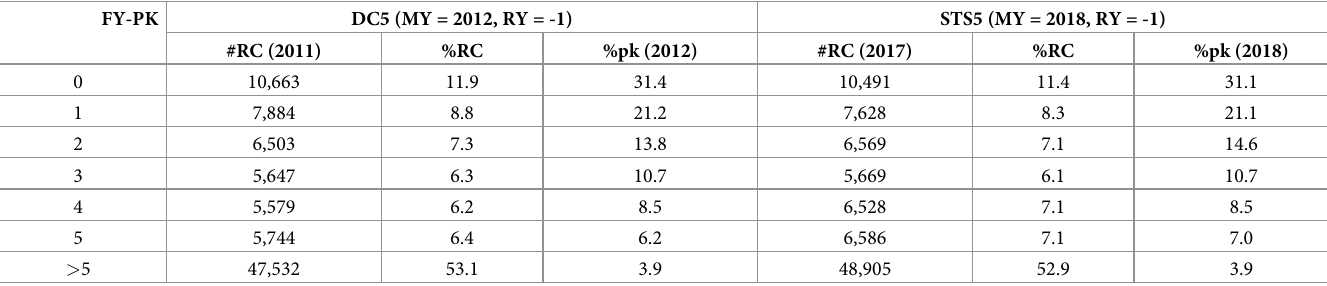
Table 4. Relationship between stage and likelihood of reaching a peak publication share in the next year. FY-PK DC5 (MY = 2012, RY = -1) STS5 (MY = 2018, RY = -1) #RC